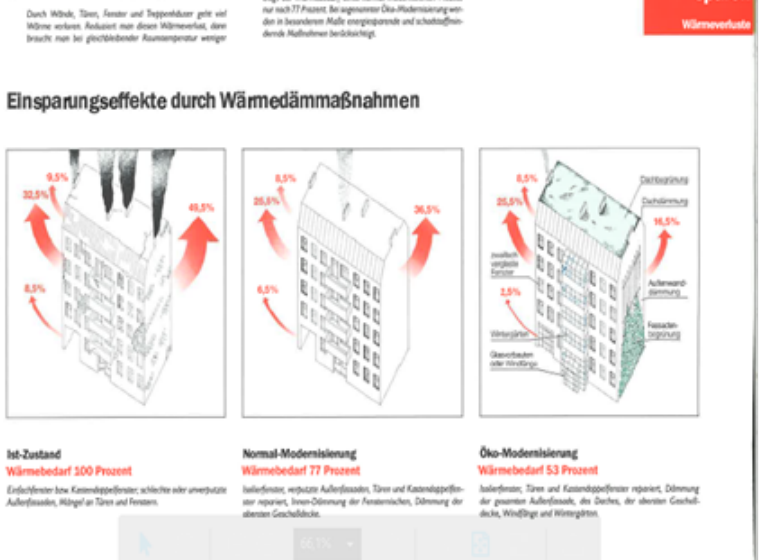
Figure 6. Information leaflet explaining cost savings through the sustainable urban renewal measurements. Source: Source: Bezirksamt Schöneberg (1992). Image rights: ÖKOLAUS—Ökologische Landschaftspflege, Architektur und Siedlungsplanung and AG